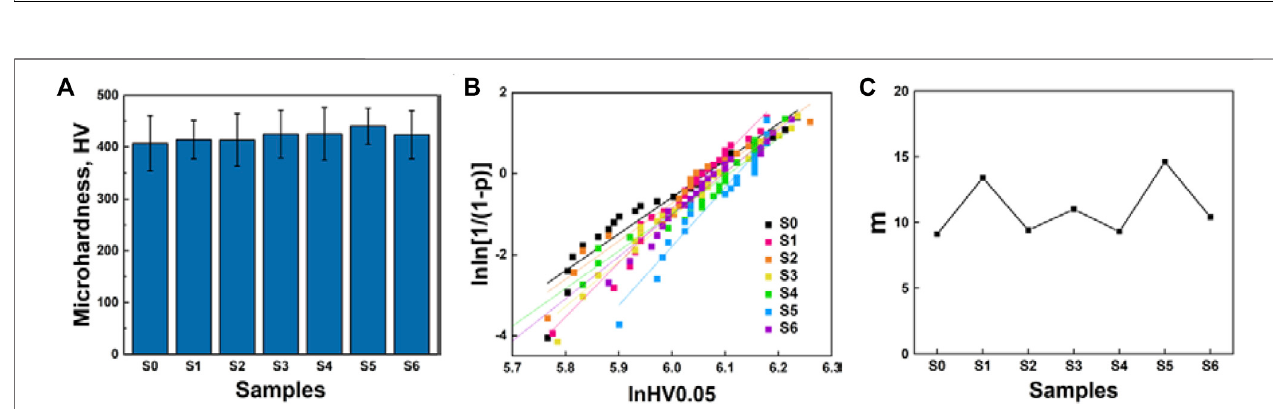
FIGURE5| MicrostructureanalysisoftheCoCrFeNiMnHEAcoatingbyTEM. (A) BrightregionshowinganFCCstructure, (B) Darkregionshowingahighdensityof nano-particles (metal oxides). The inset SAED indicating the diffraction rings of oxides.